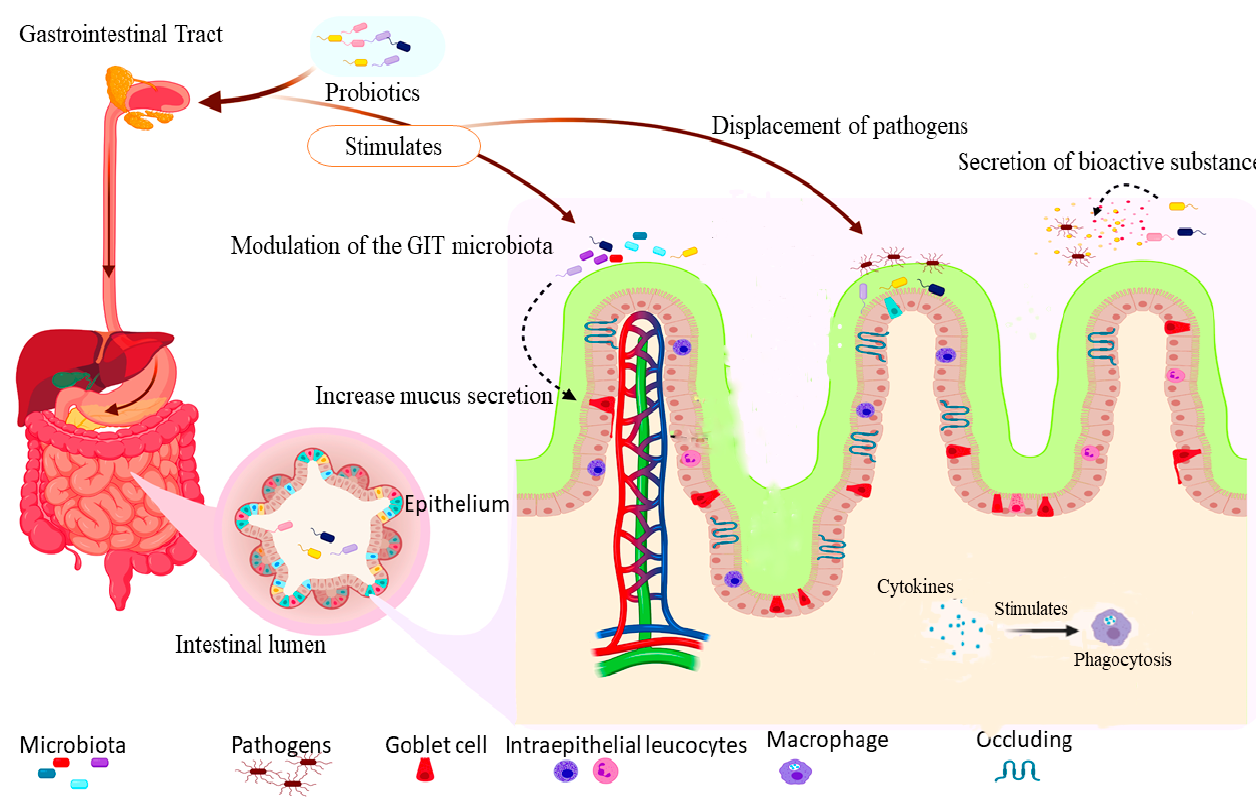
Figure 1. (created with BioRender; https://app.biorender.com/illustrations/edit/6001622bd73fad00a4e81c08, accessed on 28 November, 2020) shows the mechanism of actions of probiotics: the intake of probiotics stimulates an increase in the secretion of mucus by goblet cells, mobilization of intraepithelial leucocytes, and tightening of the tight junctions to protect against the invasion of pathogens. The increase in mucus secretion and improvement of gut microbiota enhances competitive displacement and inhibition of pathogens adhesion to the gut epithelial surface. Furthermore, the action of bioactive substances such as lysozyme and cytokines stimulate phagocytosis by macrophages.